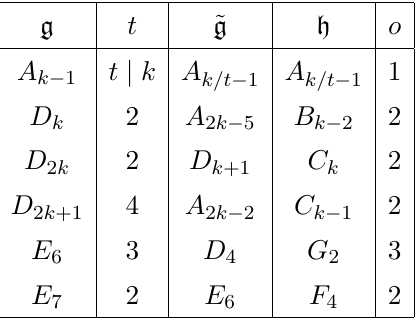
Table 3 . ~ g satisfying (3.4) for given g and t . The second row corresponds to the Stiefel-Whitney class related to the element generating (cid:25) 1 (SO(2 k )), while the third row is for the non-trivial element in (cid:25) 1 (SO(4 k ) = f 1 ; (cid:0) 1 g ) that is not induced from (cid:25) 1 (SO(4 k )). The fourth row is for the element generating (cid:25) 1 (SO(4 k +2) = f 1 ; (cid:0) 1 g ) = Z 4 . We also listed a maximal subalgebra h which is preserved by the corresponding Stiefel-Whitney class of the adjoint type Lie group of g . These h agree with the (cid:13)avor symmetry of the maximal twisted puncture of class S theory of type ~ g where the twist is of order o